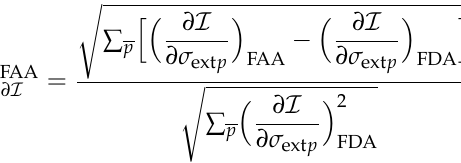
Figure 6. Partial derivatives ∂ I / ∂σ ext p at the base grid points ( x = x 0 for different values of the detector zenith angle θ 0 m . The results correspond to the solar azimuthal angle ϕ 0 = 0 ◦ and are computed with the linearized forward-adjoint approach (FAA), the linearized forward approach (FA), and the finite-difference approach